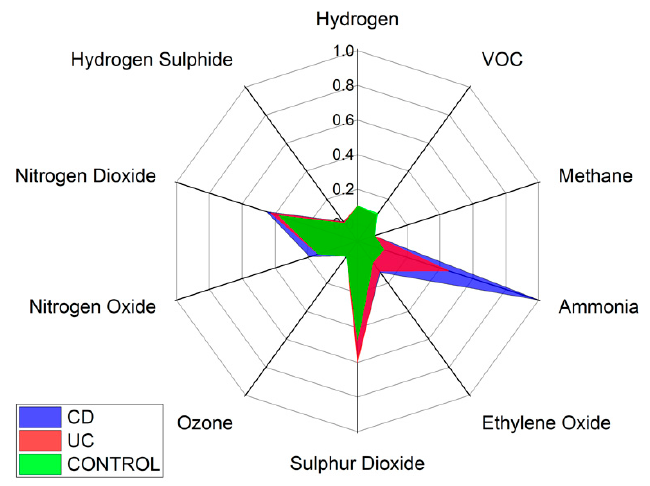
Figure 8. Wolf eNose sensor responses radar plot.